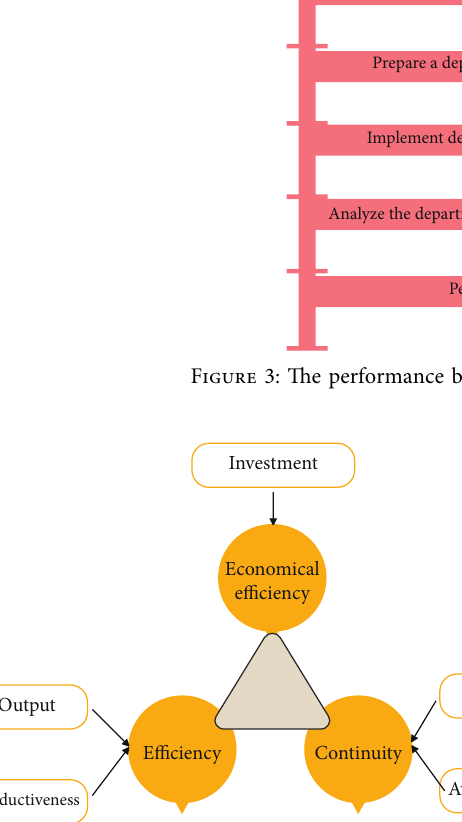
Figure 4: The relationship between the core factors of compre- hensive